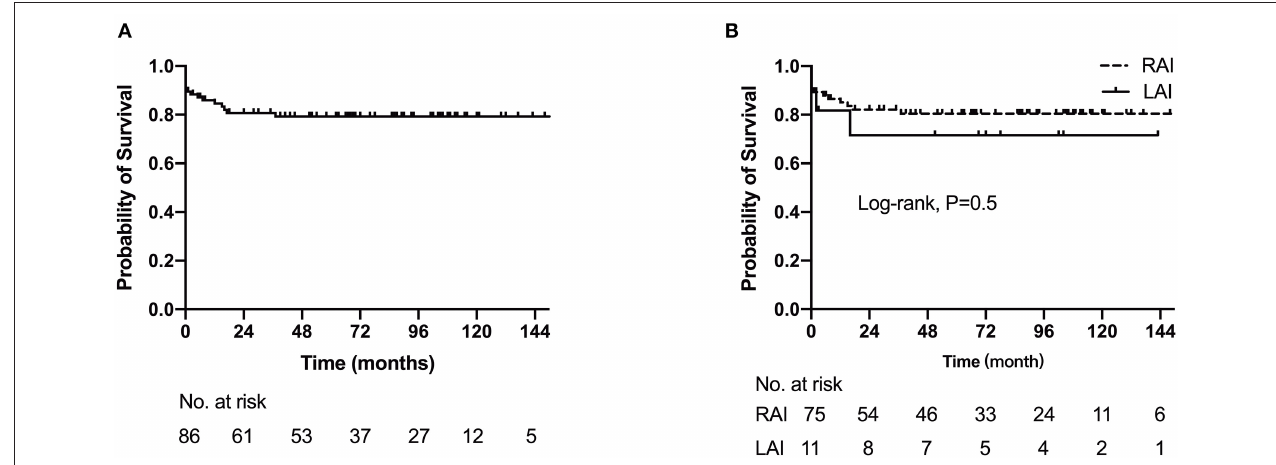
FIGURE 5 | The Kaplan–Meier curves depict estimated survival. (A) Survival for the entire cohort of 86 patients. (B) Comparison of right and left atrial isomerism survival